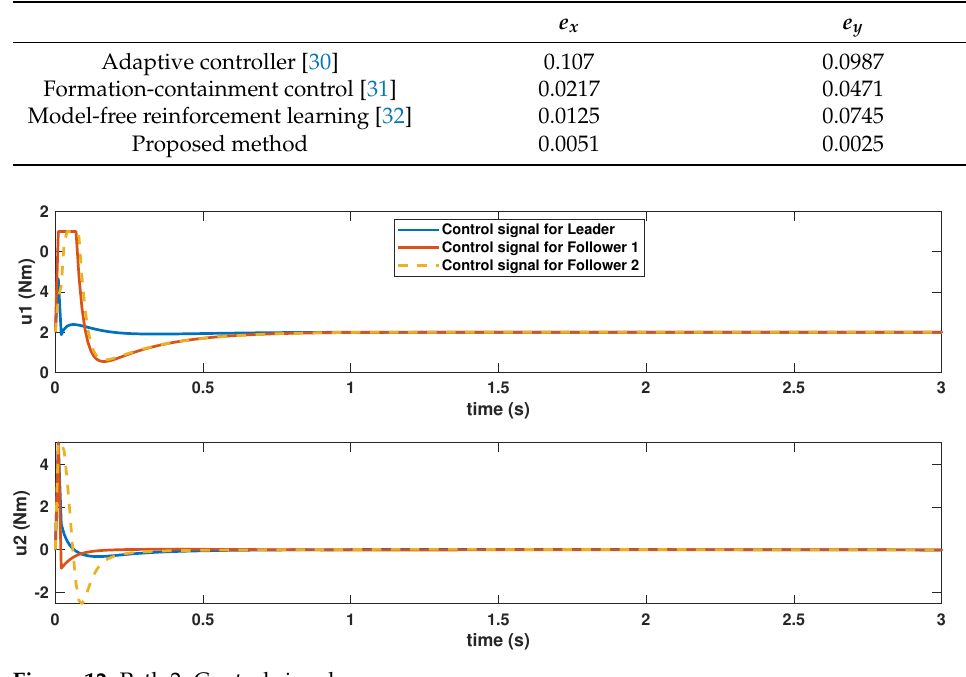
Figure 12. Path 2: Control